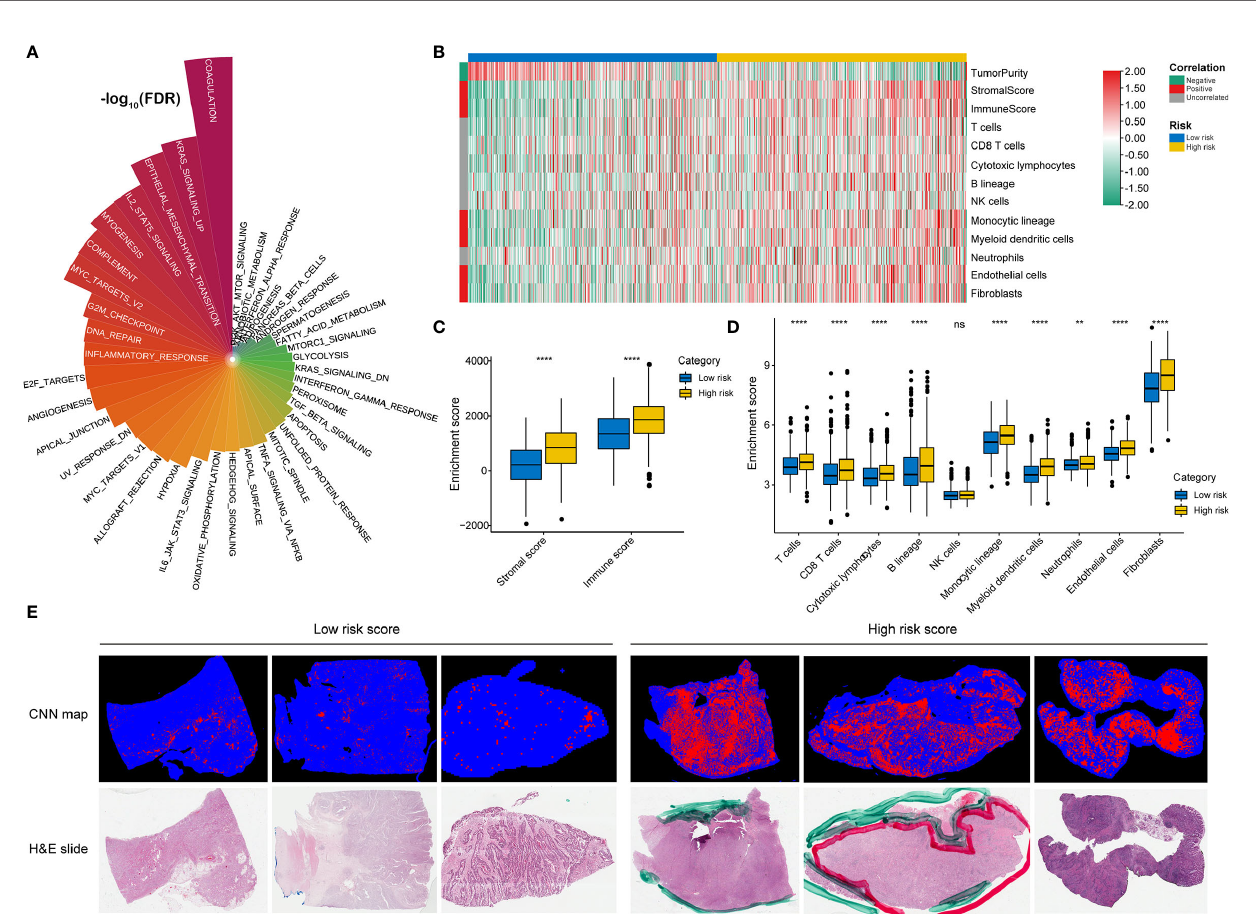
FIGURE 7 | Identi fi cation of immune heterogeneity underlying the RNA processing-related prognostic signature. (A) The differential analysis of GSVA scores between the low-risk and high-risk groups. The height and color represent the -log10(FDR). (B) Heatmap showing the immune cell in fi ltration between the high-risk and low- risk groups. (C) Differential expression of immune scores and stromal scores between the low-risk and high-risk groups. P values were obtained by the Mann- Whitney test. The asterisks represented the statistical P-value (ns, not statistical; **P < 0.01; ****P < 0.001). (D) Differential expression of immune and stromal cells between the low-risk and high-risk groups. P values were obtained by the Mann-Whitney test. The asterisks represented the statistical P-value (ns, not statistical; **P < 0.01; ****P < 0.001). (E) Tumor-in fi ltrating lymphocyte in fi ltration between the low-risk and high-risk groups determined by hematoxylin – eosin (H&E) whole-slide images. Red represents a positive TIL patch; blue represents a tissue region with no TIL patch, while black represents no